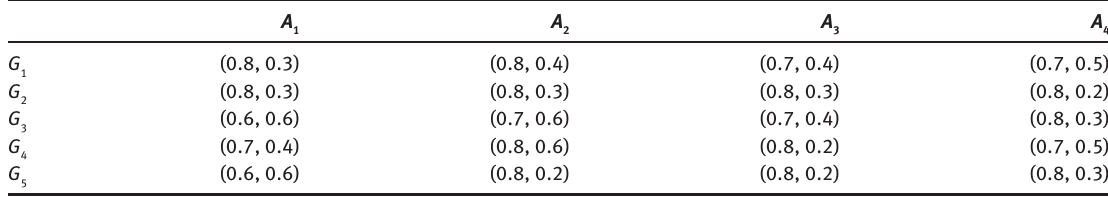
Table 4: Pythagorean Fuzzy Decision Matrix D 4 .